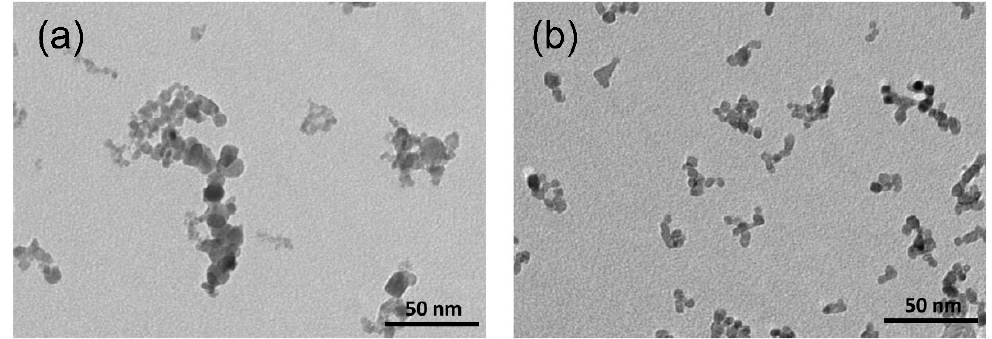
Figure 3. TEM micrographs of suspensions of ATOu ( a ) and ATOc ( b ) in ethyl alcohol.